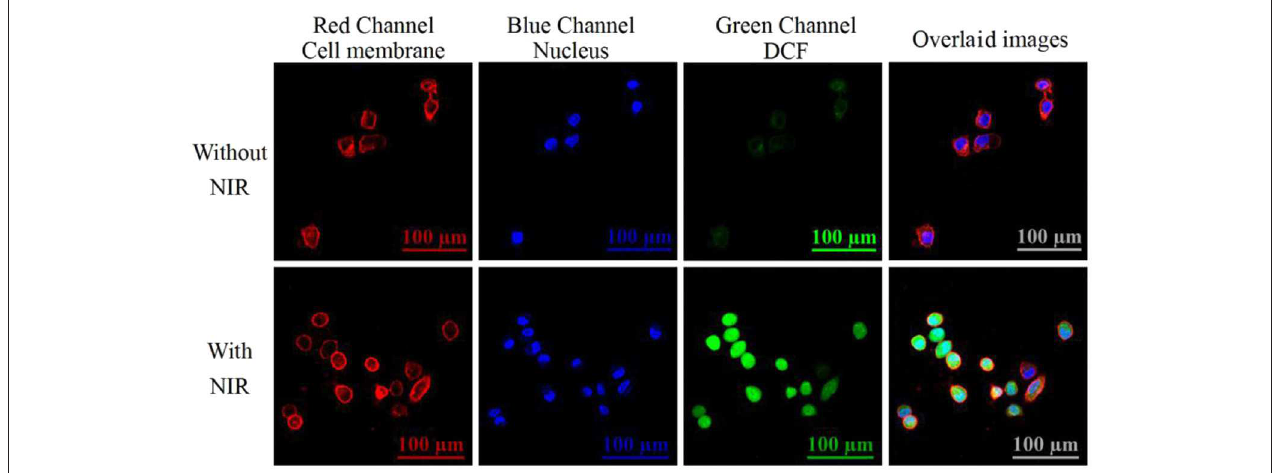
FIGURE 6 | Confocal lasers scanning microscope (CLSM) images of intracellular ROSs. MCF-7 cancer cells were incubated with 70 µ g/mL of the prepared nanotheranostic agent for 12h. The cell membrane information was collected at the red channel from 600 to 650nm under the excitation of 561nm laser. The nucleus information was collected at the blue channel from 420 to 480nm under the excitation of 405nm laser; The ROSs information was collected at the green channel from 500 to 540nm under the excitation of 488nm. Overlaid images consisted of the three channels.